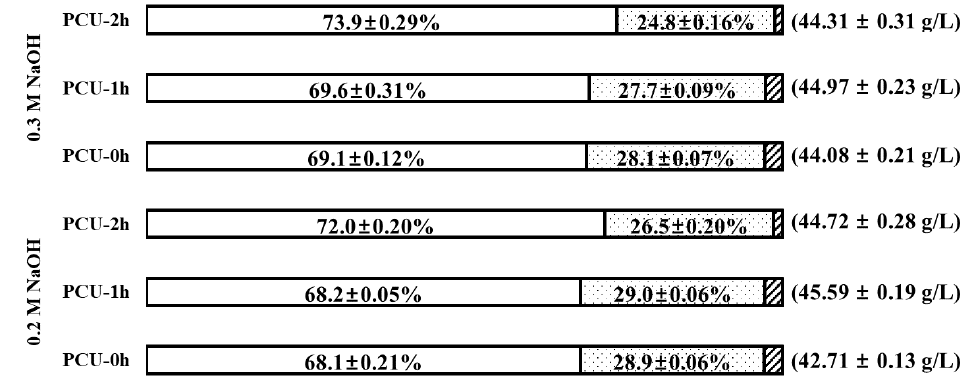
Figure 5. Percent distribution of individual sugars (glucose, xylose, and arabinose) and total sugar after 72 h enzymatic saccharification for the pretreatment combined with ultrasonication (PCU). The numbers in parentheses indicate the concentration of total sugars. Symbols: glucose (blank), xylose (dots), and arabinose (diagonal).